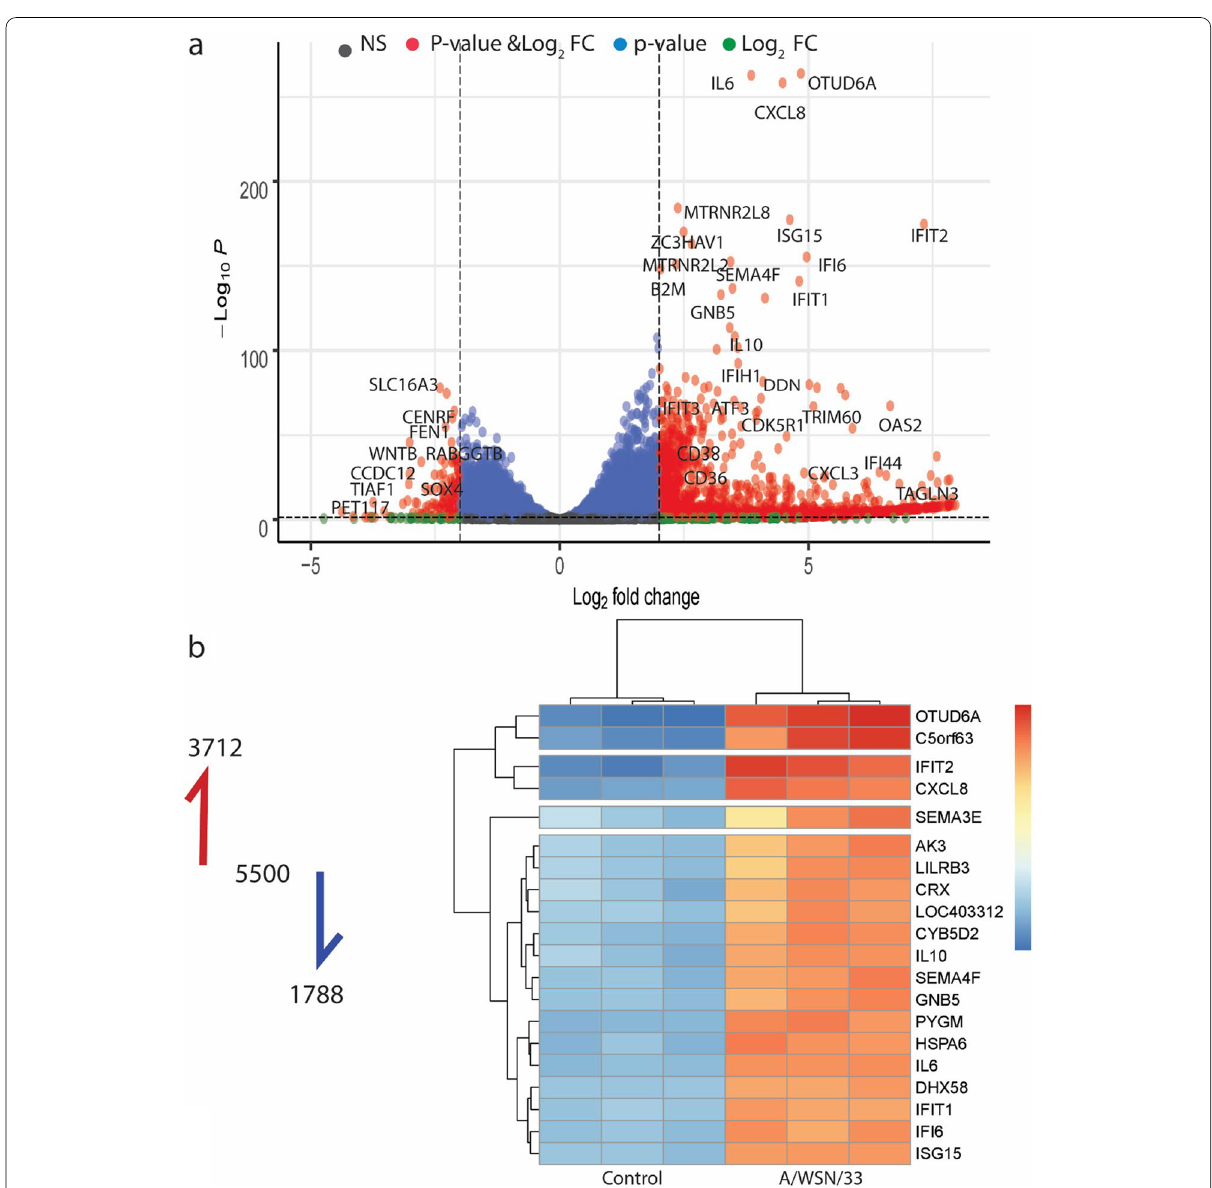
Fig. 3 Transcriptomic analysis of human brain microvascular endothelial cells (hBMECs) following infection with Influenza A virus. a Volcano plot of host genes differentially expressed at 12 hpi (padj < 0.05) and 2 log2FC change. Each dot represents a gene. The red, blue, green, and black dots ± represent the differentially expressed genes within the selected p -value (padj < 0.05) and log2FC 2, the p -value, the log2FC, and non-significant ± genes, respectively. b Heatmap of the top 20 genes induced in hBMECs treated with the A/WSN/33 compared to the control cells at 12 hpi (padj < 0.05), the genes are listed on the Y-axis. Each column represents one sample, the control cells are represented in three columns (replicates), and the same case is for the treatment. The overall number of differentially expressed genes is 5,500, among which 3,712 were up-regulated and 1,788 were down-regulated (|log2FC| 1; padj < 0.05) A list of the differentially expressed genes is available in Supplementary file ≥